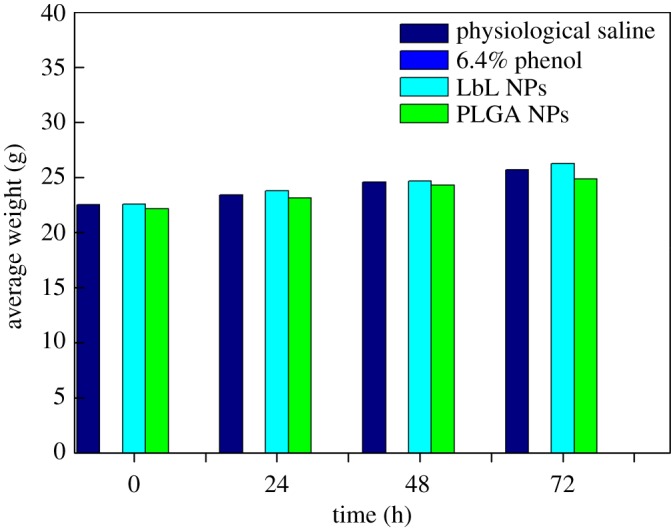
Weight gain in mice.